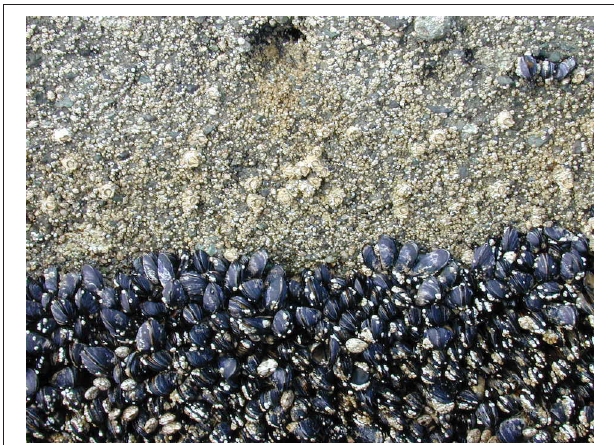
FIGURE 1 | Zonation pattern of mussels and barnacles. The upper intertidal limit to intertidal organisms is generally assumed to be driven by physiological stress and feeding time ( Connell, 1961; Wethey, 1983, 1984; Gilman and Rognstad,